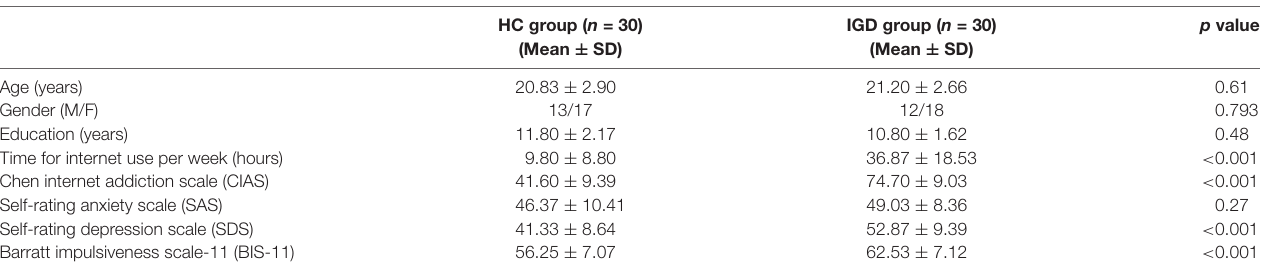
TABLE 1 | Demographic and behavioral characteristics of the included